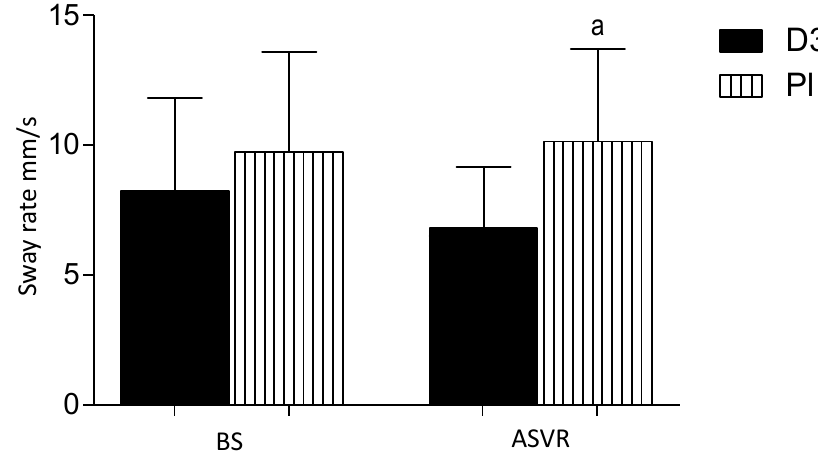
Figure 7. Vitamin D supplementation decrease sway rate (mm/s) in patients after anterior cervical interbody fusion surgery. Columns, mean and bars, standard deviations (SDs). a, p < 0.05, significantly different compared with ASVR D3 by one-way ANOVA.